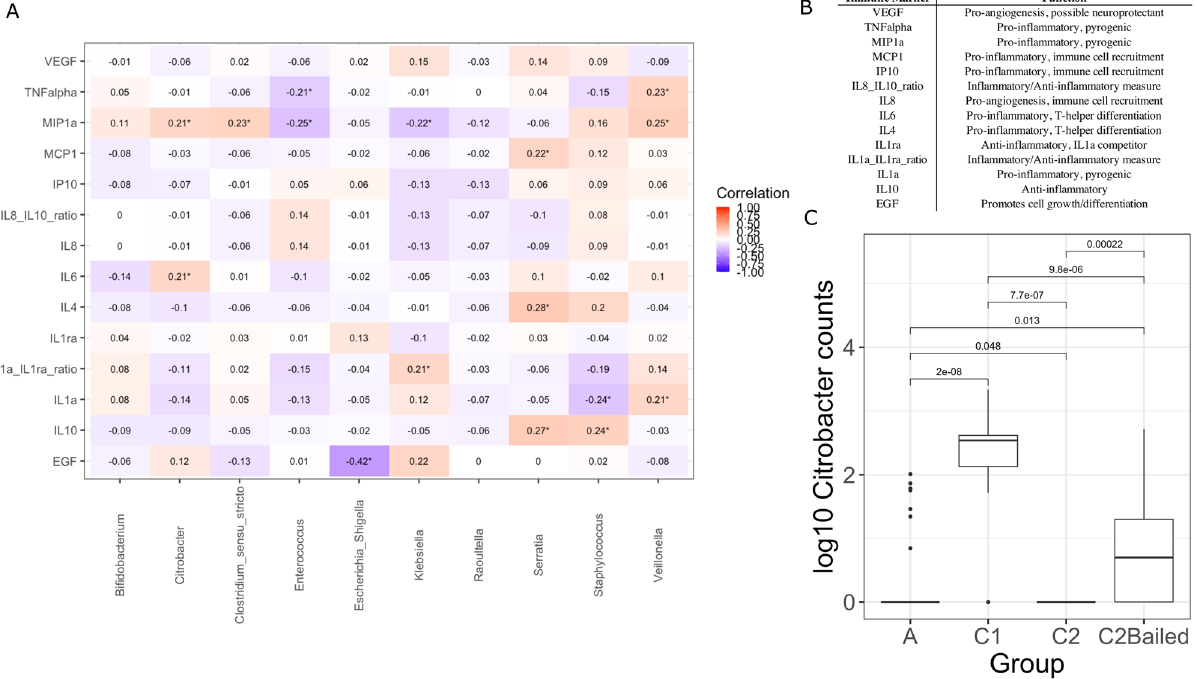
Figure 7. Stool immune marker levels show modest correlation with gut microbiota. ( A ) Heatmap of repeated measures correlation coefficients between immune markers measured from stool and the most